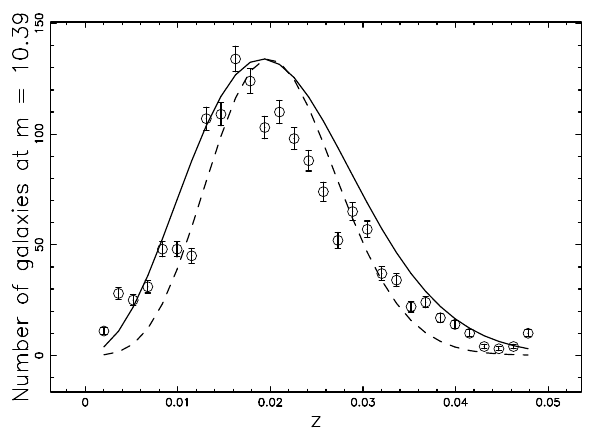
L (cid:12) L (cid:12) ≤ f ≤ 1,384,350 Figure 6. The galaxies of the 2MRS with 10.28 ≤ m ≤ 10.44 or 1,202,409 Mpc 2 Mpc 2 are organized in frequencies versus heliocentric redshift, (empty circles); the error bar is given by the square root of the frequency. The maximum frequency of observed galaxies is at z = 0.018. The full line ( z ) as given by the application of the Schechter LF which is is the theoretical curve generated by dN d Ω dzdf Equation (43) and the dashed line represents the Lindley LF which is Equation (47). The parameters are the same of Table 4, χ 2 = 198 for the Schechter LF and χ 2 = 191 for the Lindley LF.